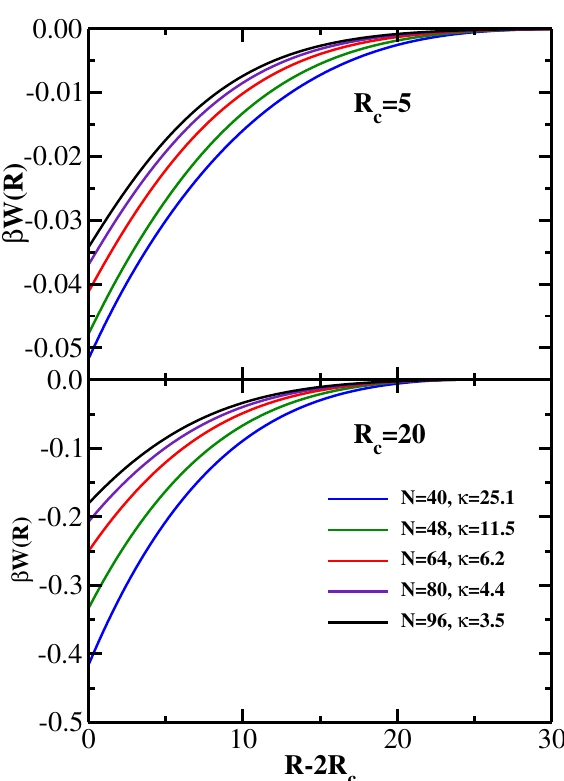
Figure 1. Dimensionless colloid − colloid β W ( R ) as a function of colloid separation R − 2 R c for five values of the stiffness parameter κ as indicated in the legend. The monomer bulk density is fixed at ρ = 0.001. Upper panel: colloid radius R c = 5; Lower panel: colloid radius R c =